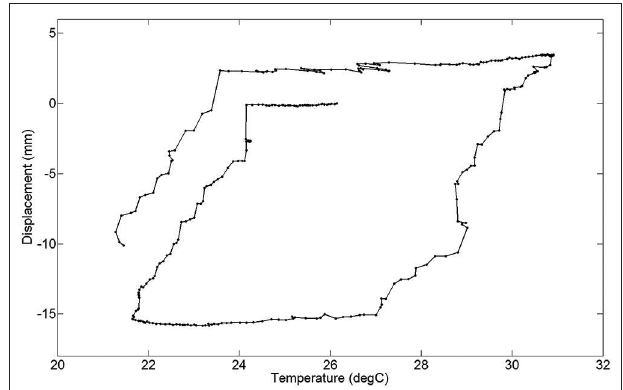
FIGURE 8 | Example “stick-slip” behavior at the Pier A